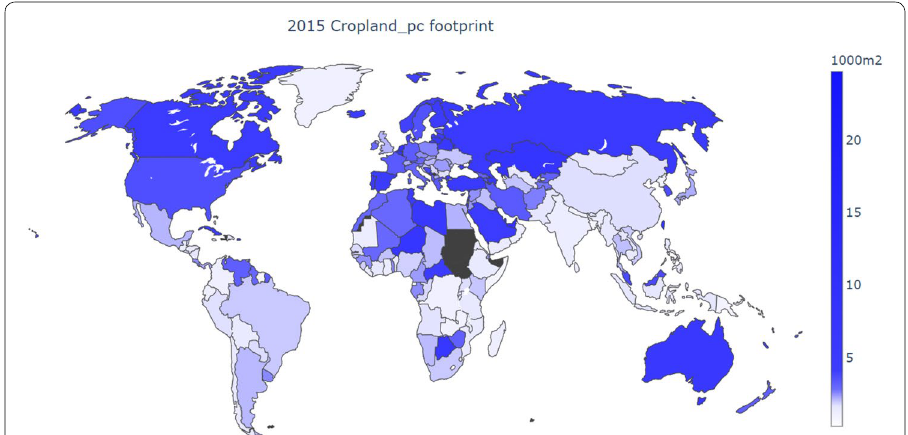
Fig. 2 Map of cropland footprints per capita for year 2015 for 214 countries. Unbalanced countries in dark gray (Comoros, Haiti, Liechtenstein, South Sudan and